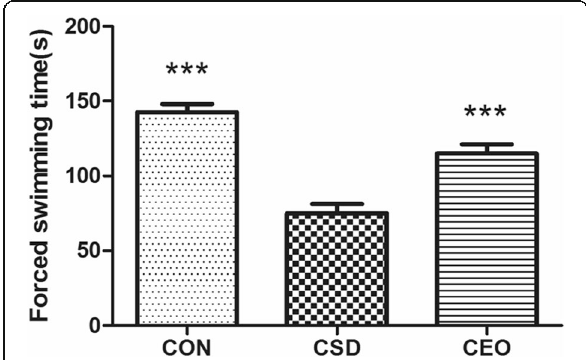
Fig. 3 Swimming time of weight loaded forced swimming test. All data were represented as the mean±SEM ( n =11), *** refers to p <0.001 vs CSD group. The swimming time of CON group was significantly longer compared with CSD group, CEO increased the swimming time significantly compared with the CSD